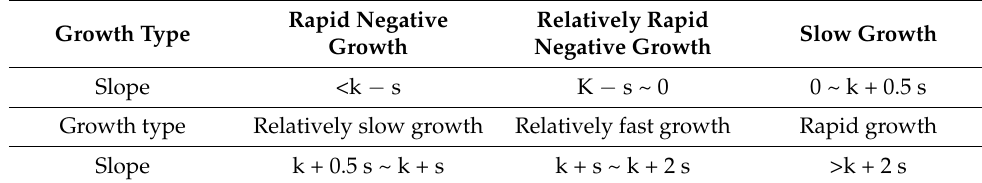
Table 2. Change trend classification. Growth